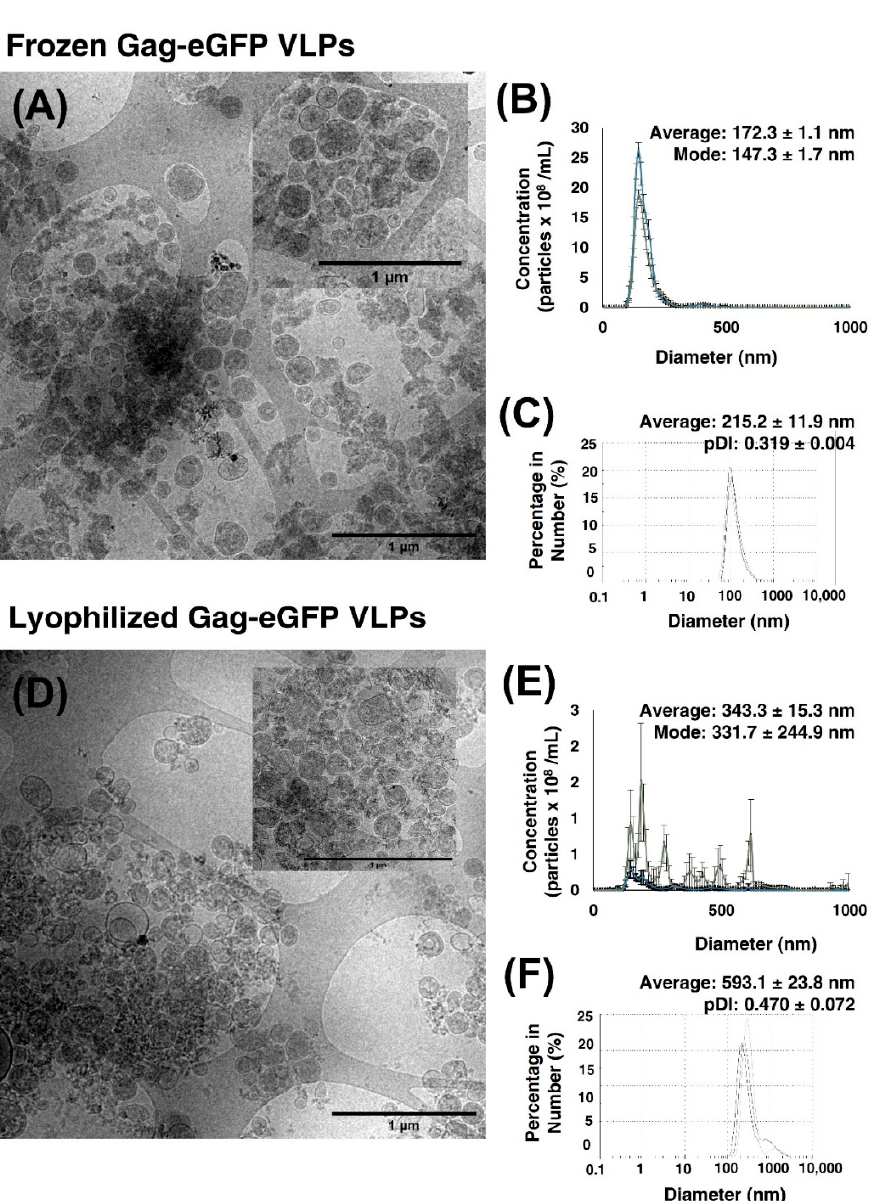
Figure 6. Biophysical characterization of purified Gag-eGFP VLPs. The purified nanoparticles were stored under different conditions for two months after SEC. ( A – C ) Frozen Gag-eGFP VLPs ( D – F ) Lyophilized Gage-GFP VLPs. ( A , D ) Cryo-TEM micrographs of the purified material, respectively. ( B , E ) PSD analysis by NTA of total nanoparticles (blue line) measured by light scattering or VLPs (gray line) measured with the fluorescence filter. Gag VLP concentration of 12.6 ± 0.7 × 10 9 particles/mL and EV concentration of 9.9 ± 0.4 × 10 9 particles/mL were obtained in frozen samples, whereas a VLP concentration of 2.2 ± 0.8 × 10 9 particles/mL and an EV concentration below LOD was obtained after lyophilization ( C , F ) PSD analysis with DLS. Three independent measurements were performed. Average: mean hydrodynamic diameter; PDI: polydispersity index.